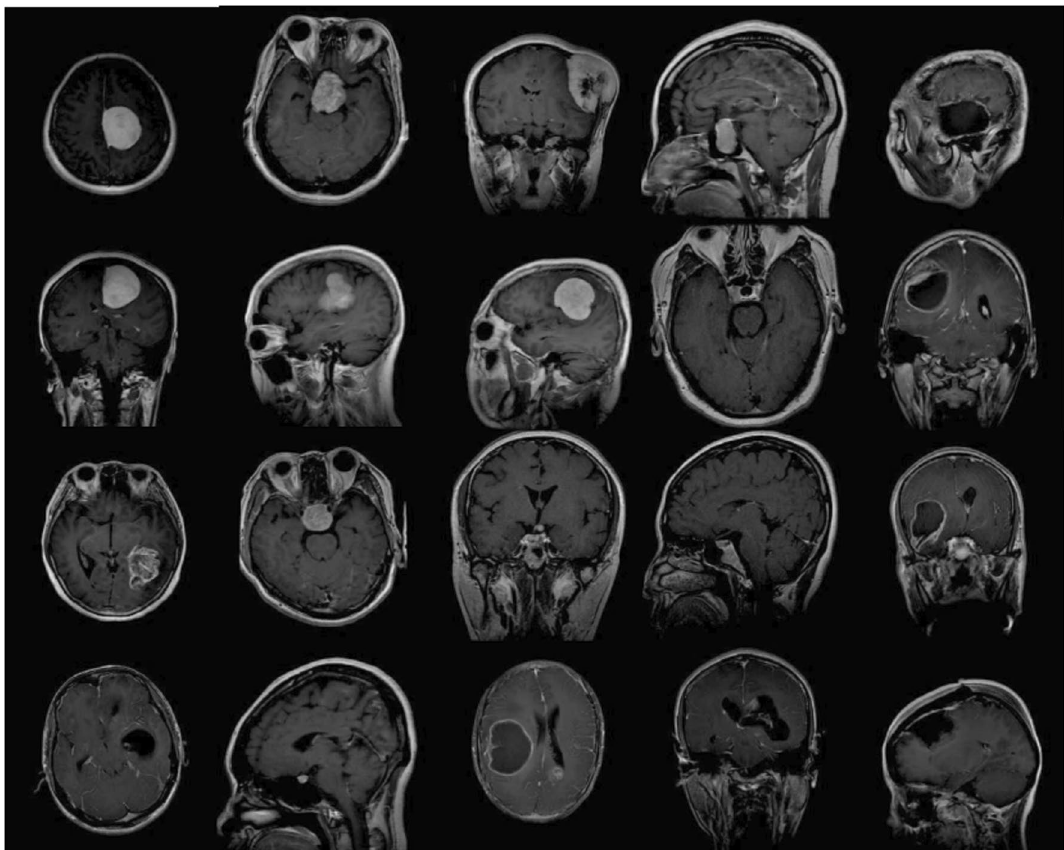
Fig. 5 Sample dataset for three brain